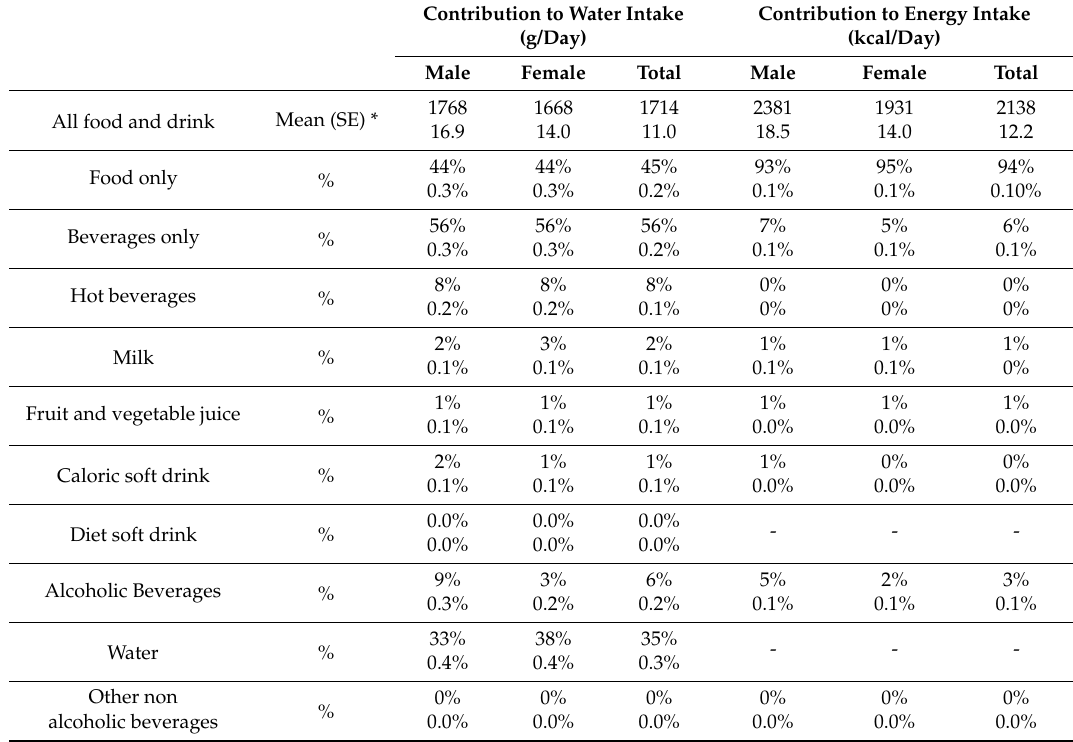
Table 1. Contribution of food and beverages to total water and energy intake.